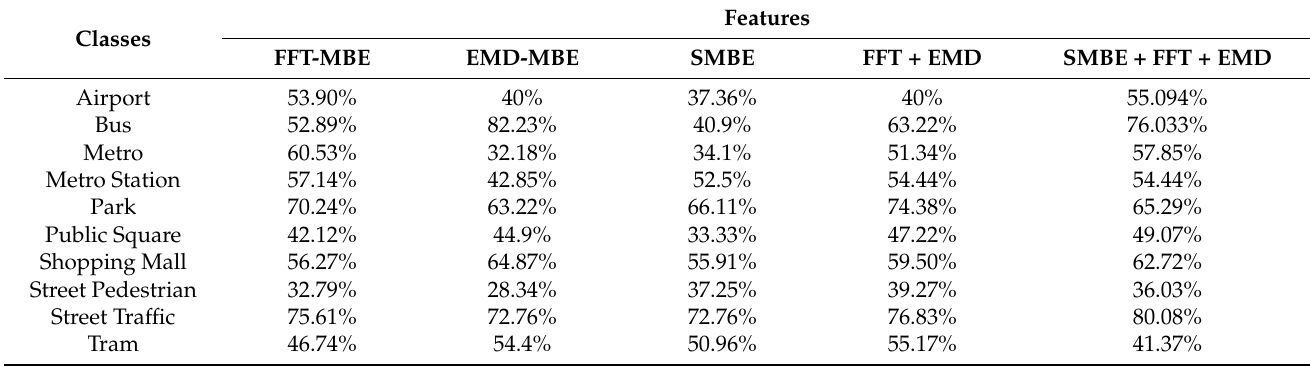
Table 3. Classification accuracy of each class for the Acoustic Scene Classification Datase.